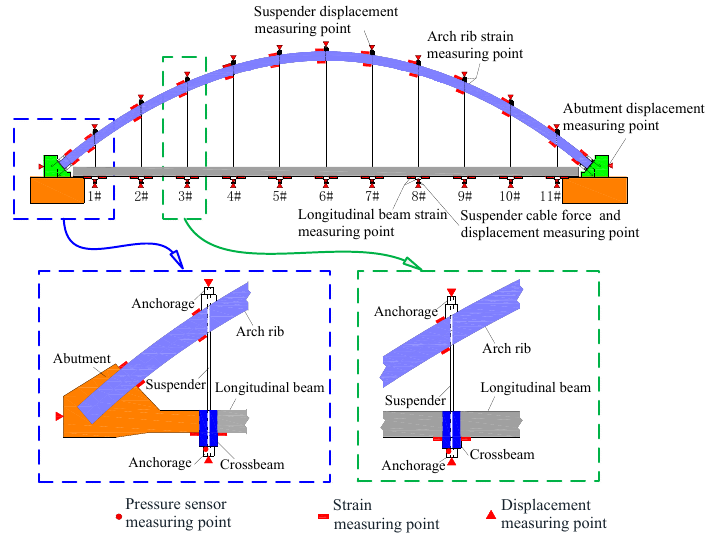
Figure 9. The layout of the measuring points.